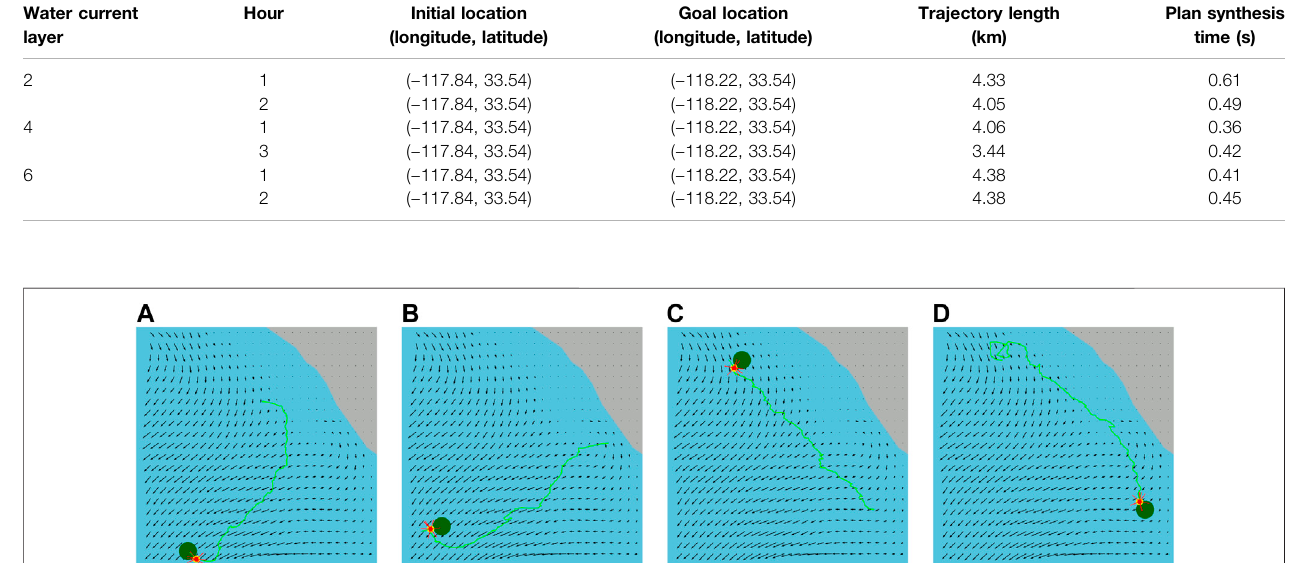
Hour Initial location (longitude, latitude)